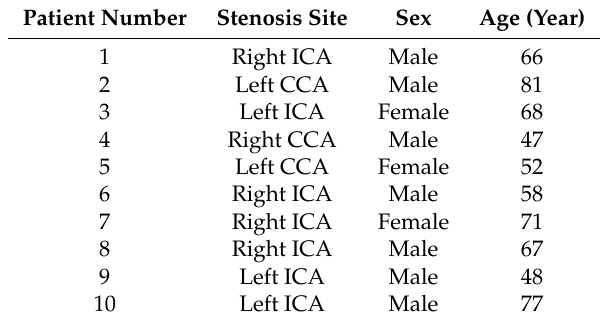
Table 1. Overview of stenosis site, sex, and age for the patients (n = 10) included in the study